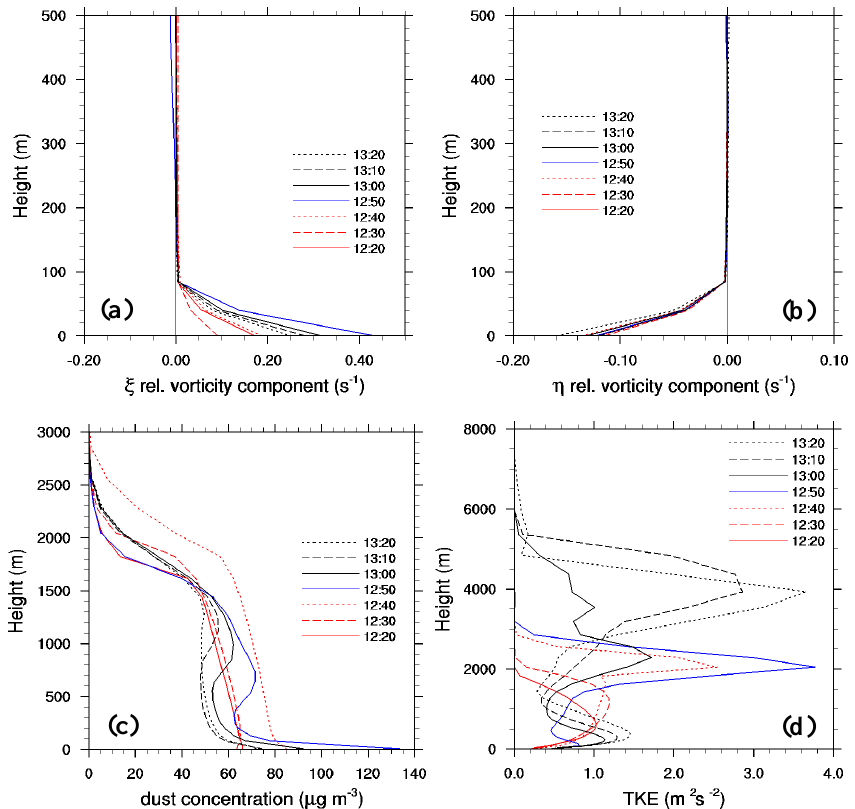
Fig. 8. Vertical profiles at lat = 31.81, lon =− 4.39 during the passage of the storm (12:20–13:20) on 31 May 2006. (a) ξ horizontal relative vorticity component (s − 1 ) . (b) η horizontal relative vorticity component (s − 1 ) . (c) Dust concentration (µgm − 3 ) (d) TKE (m 2 s − 2 )